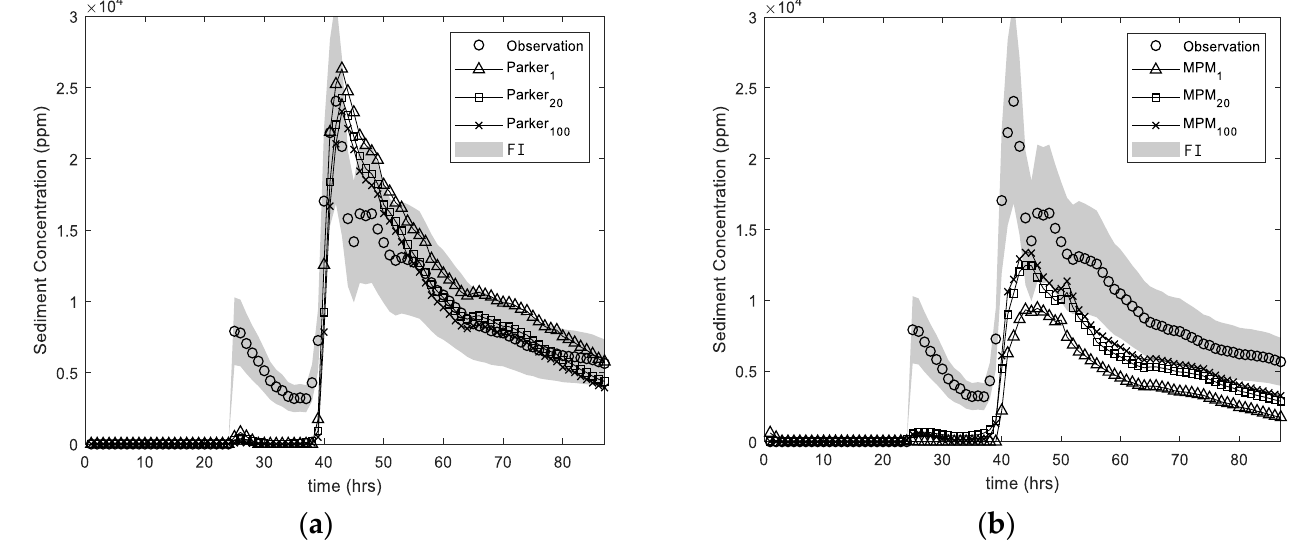
Figure 8. Comparison of the simulated and measured data, ( a ) Parker; ( b ) MPM.